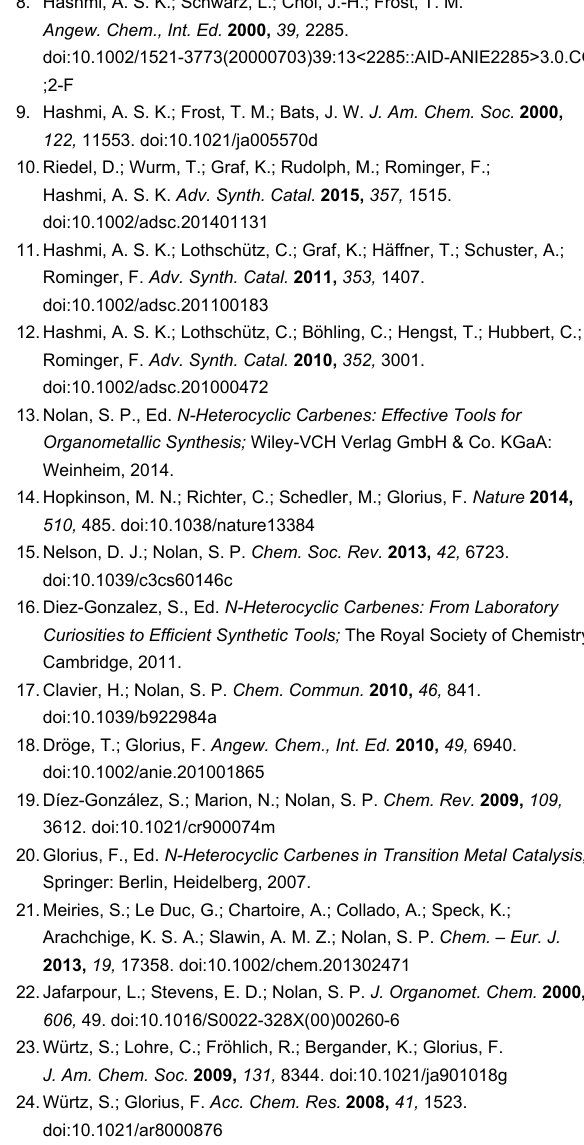
[Au(IHept)(NTf 2 )] ( 8 ) [Au(INon)(NTf 2 )] ( 9 )